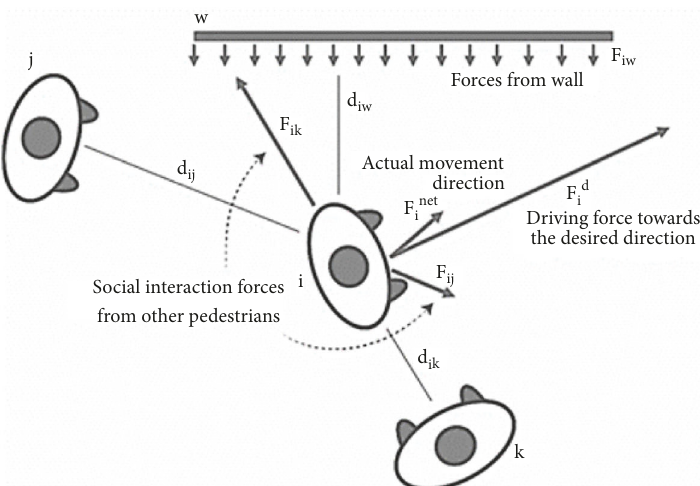
Figure 8: Visualillustrationof the finalmodelling stepof thesimulation process,thestep-taking model.Thislayer of simulation isa calibrated social-force module. The virtual forces from other agents and the walls as well as the driving force of the agent (determined by the local pathfinding algorithm illustrated in Figure 7) are calculated and the net force determines the point is space to which the pedestrian moves at each time step of the simulation